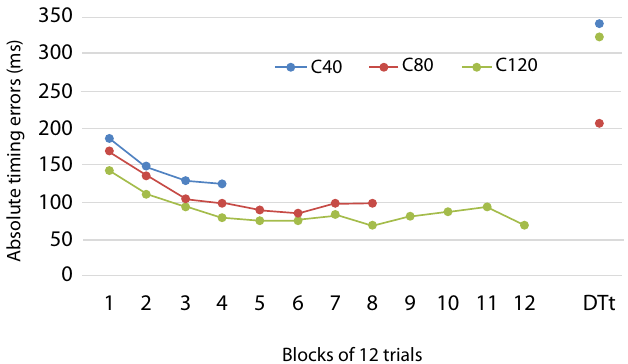
Figure 11 . Absolute timing errors ( A E) in acquisition and transfer test (Tt).